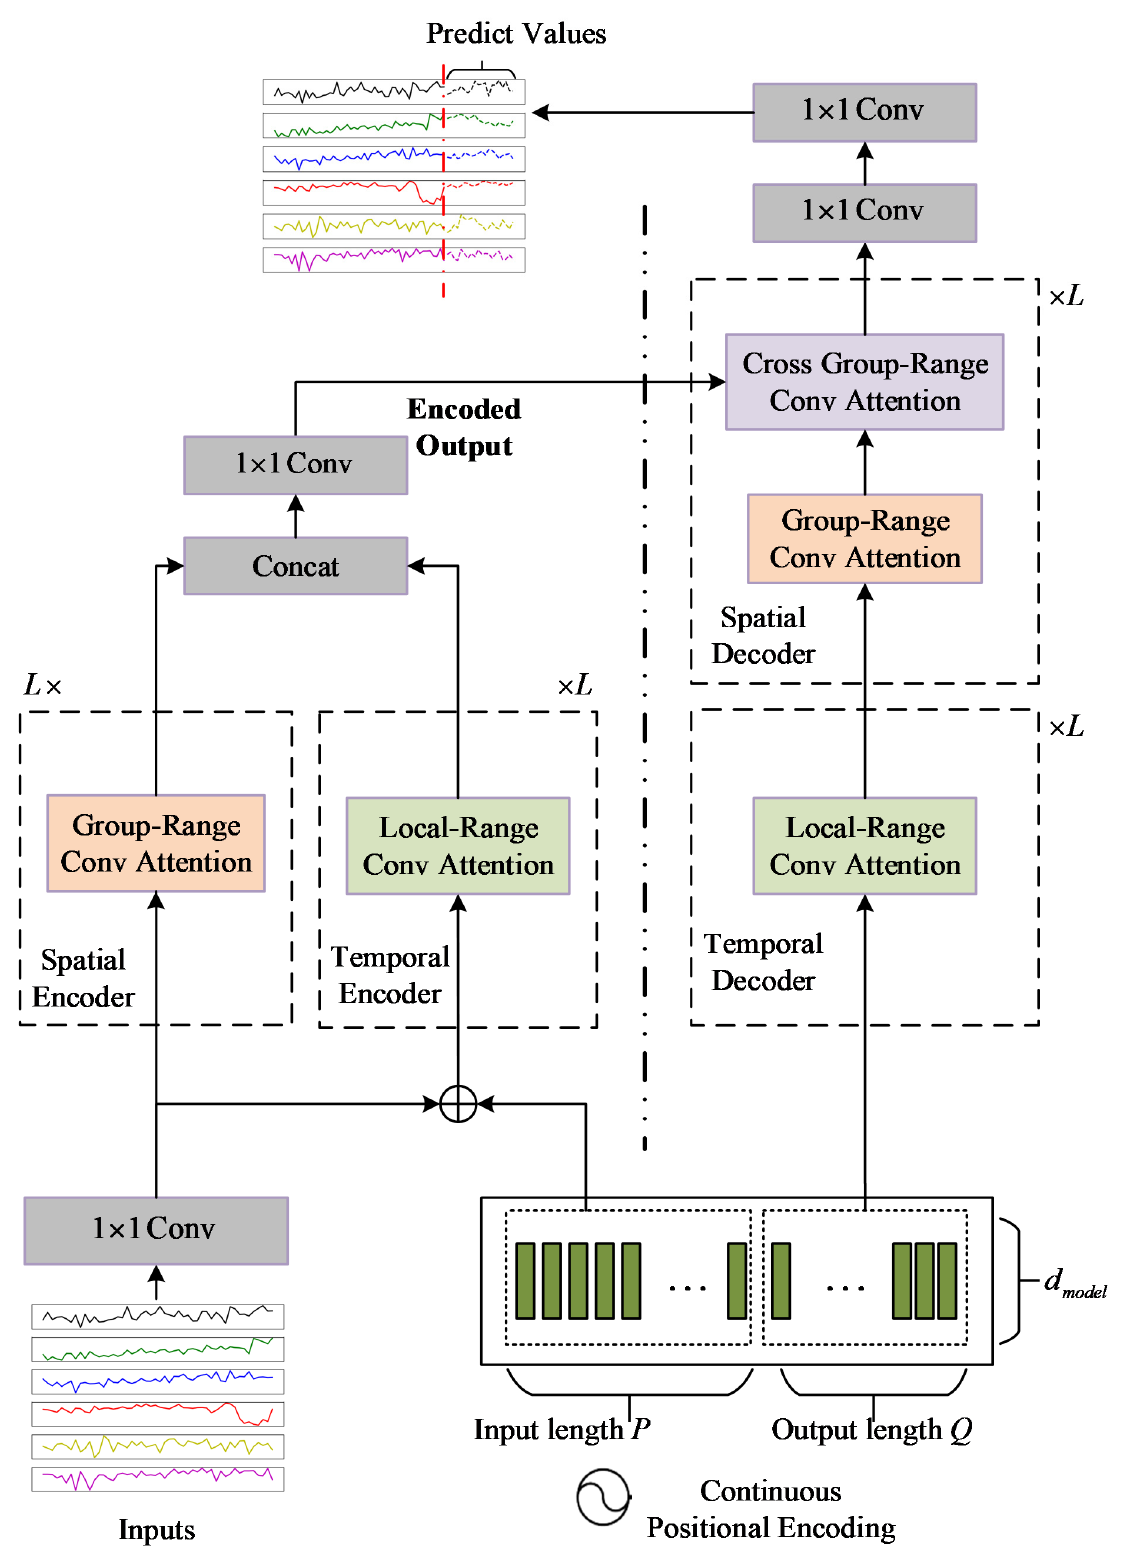
Figure 1. The framework of STCTN. “ ⊕ ” denotes the elementwise addition. For simplicity, we hide all the residual connections, layer regularizations, and fully connected feed-forward networks that are similar to the standard Transformer [35].